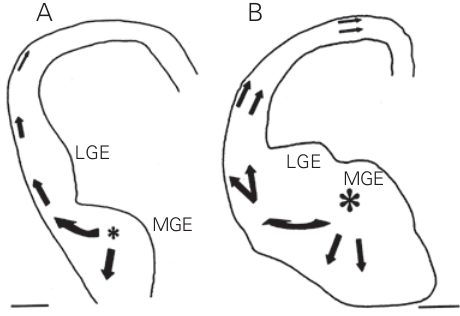
Figure 2. Camera lucida drawings of coronal sections through part of the rat forebrain after placement of Di (cid:1) crystals in the medial ganglionic eminence (MGE) at E14 (A) and E16 (B). Arrows indicate the direction of migration of labeled cells in the cortical primordium 2 days (A) and 3 days (B) after Di (cid:1) application. In A , fluorescent cells appeared as a stream rounding the